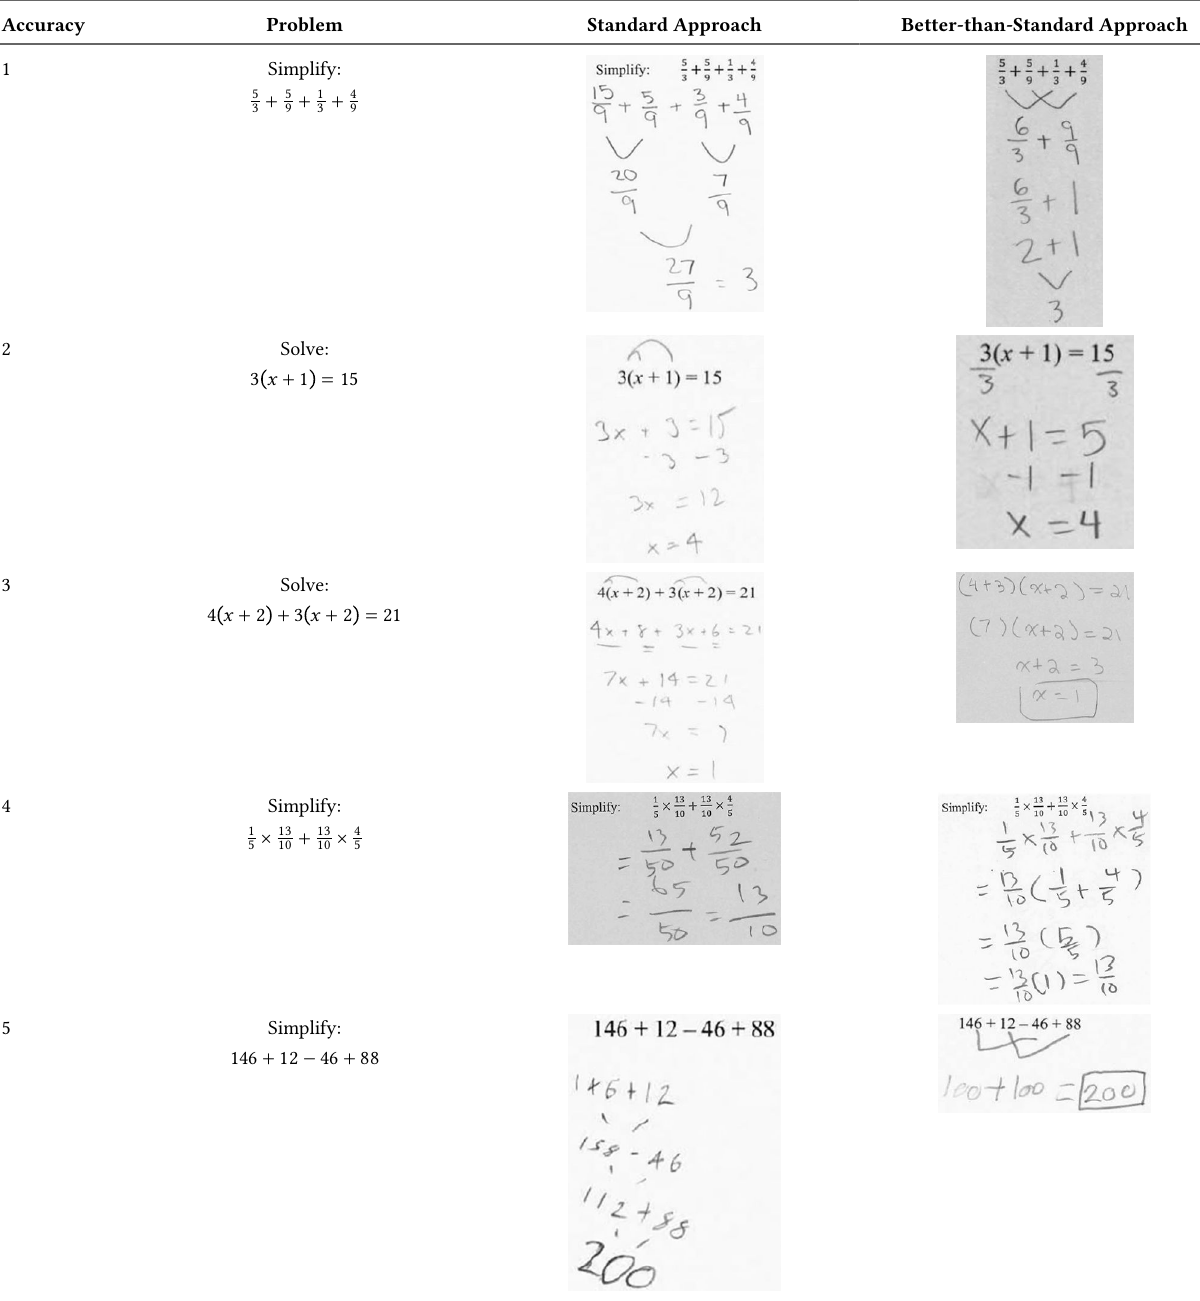
Problems Attempted in Parts 1 and 2 of the Assessment and Examples of Standard and Better-Than-Standard Solution